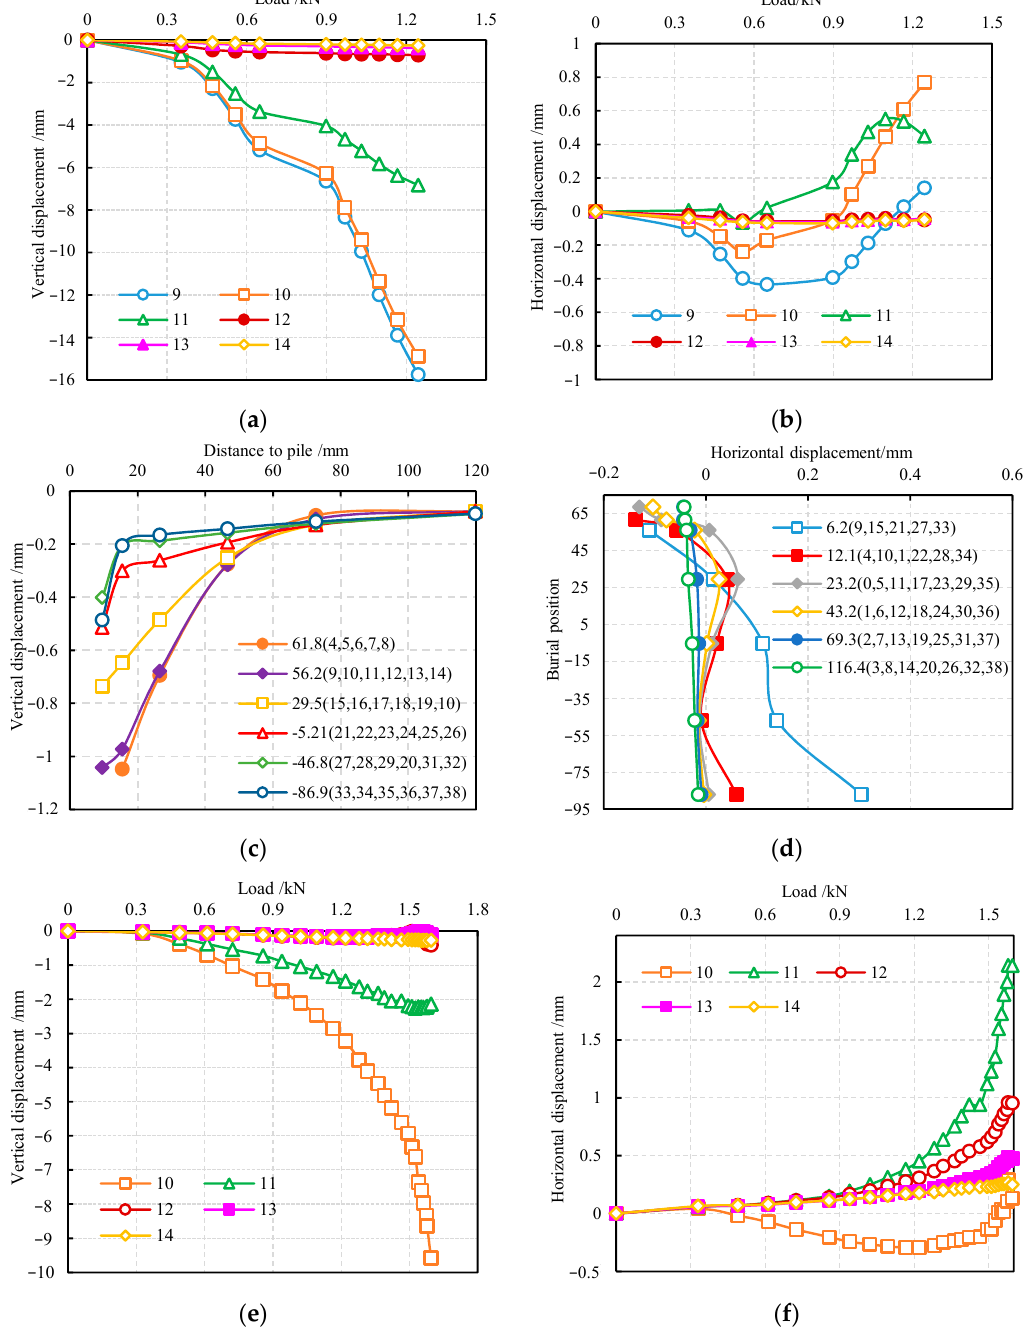
Figure 13. Relationships between displacement and load at different positions of the same burial depth around the pile: ( a ) relationship between vertical displacement and loads in the undisturbed soil; ( b ) relationship between horizontal displacement and loads in the undisturbed soil; ( c ) relationship between vertical displacement and positions in the undisturbed soil (load: 0.352 kN); ( d ) relationship between horizontal displacement and burial position in the undisturbed soil (load: 0.352 kN); ( e ) relationship between vertical displacement and loads in the sand; ( f ) relationship between horizontal displacement and loads in the sand.